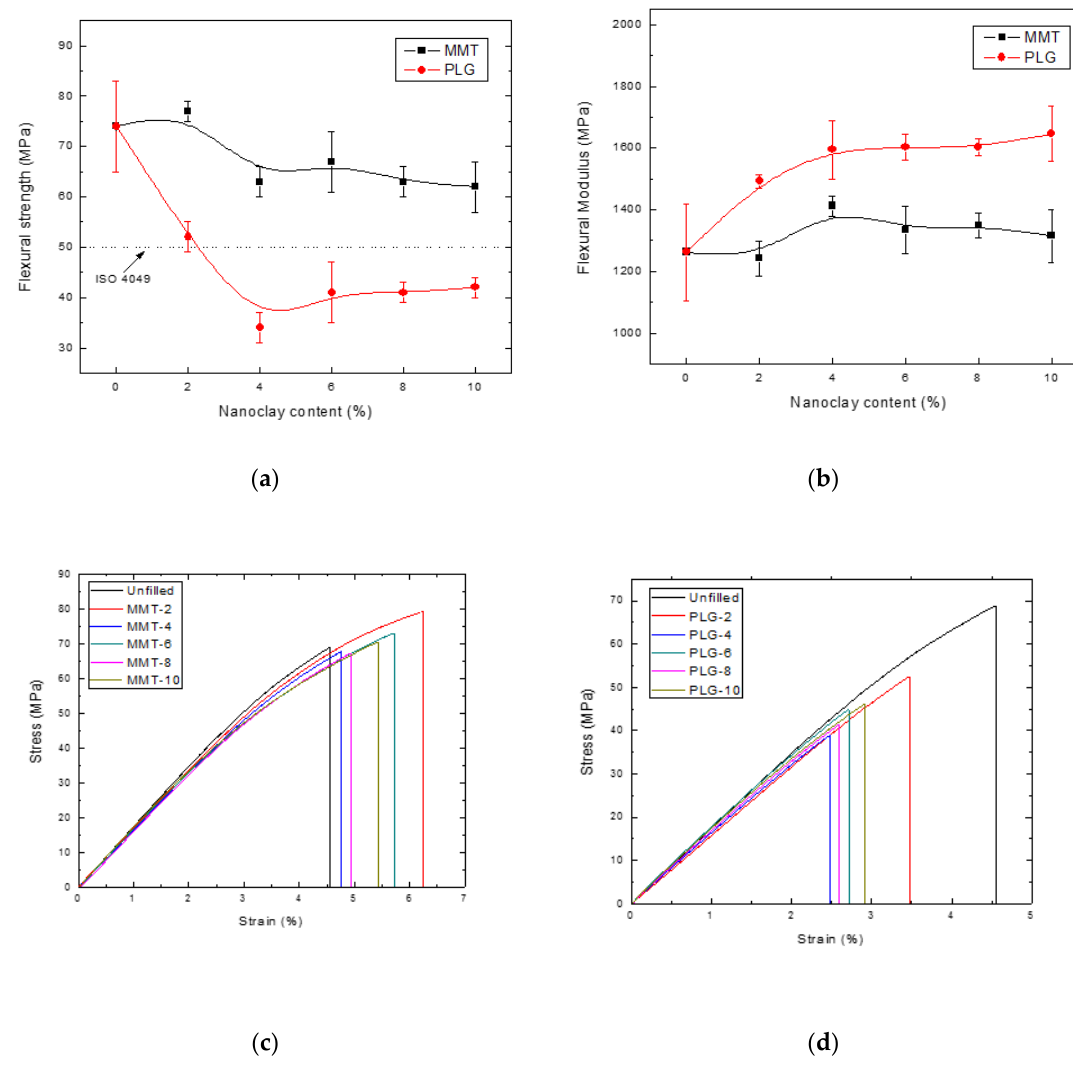
Figure 3. Flexural properties of dental resin composites: ( a ) Strength; ( b ) modulus; ( c ) stress–strain curves for nanocomposites prepared with MMT and ( d ) stress–strain curves for nanocomposites prepared with